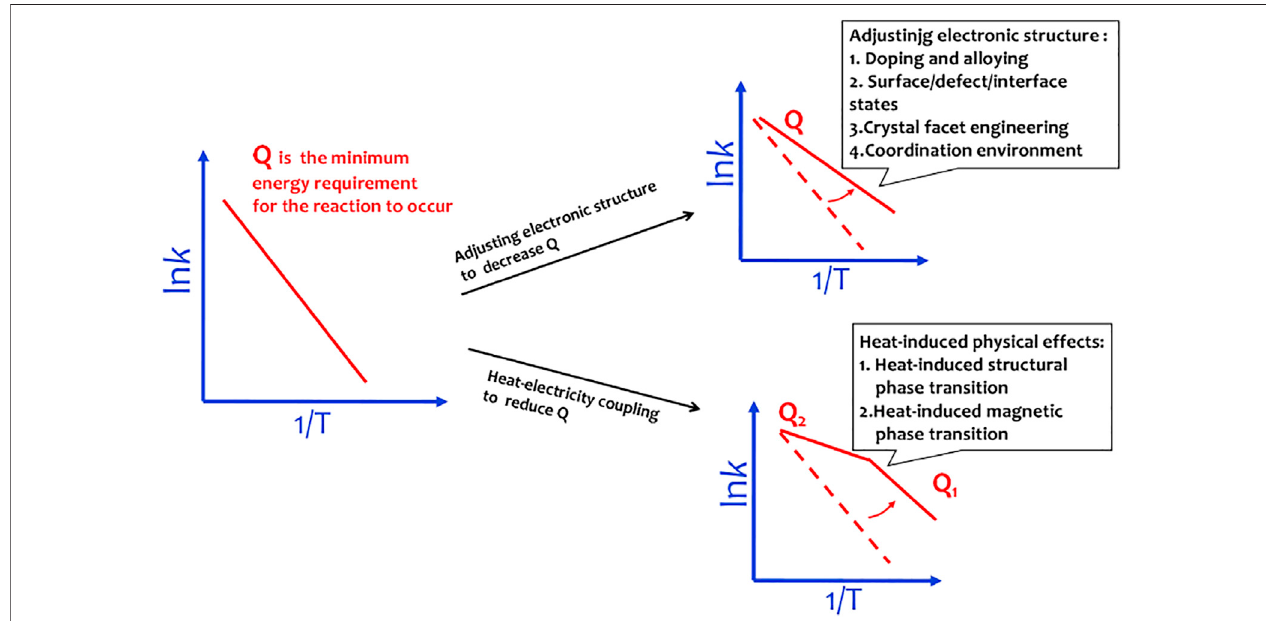
FIGURE 5 | Materials designed by adjusting electronic structures to decrease activation energy follow the linear Arrhenius relationship. The materials with heat- induced physical effects can induce a sudden change in activation energy.